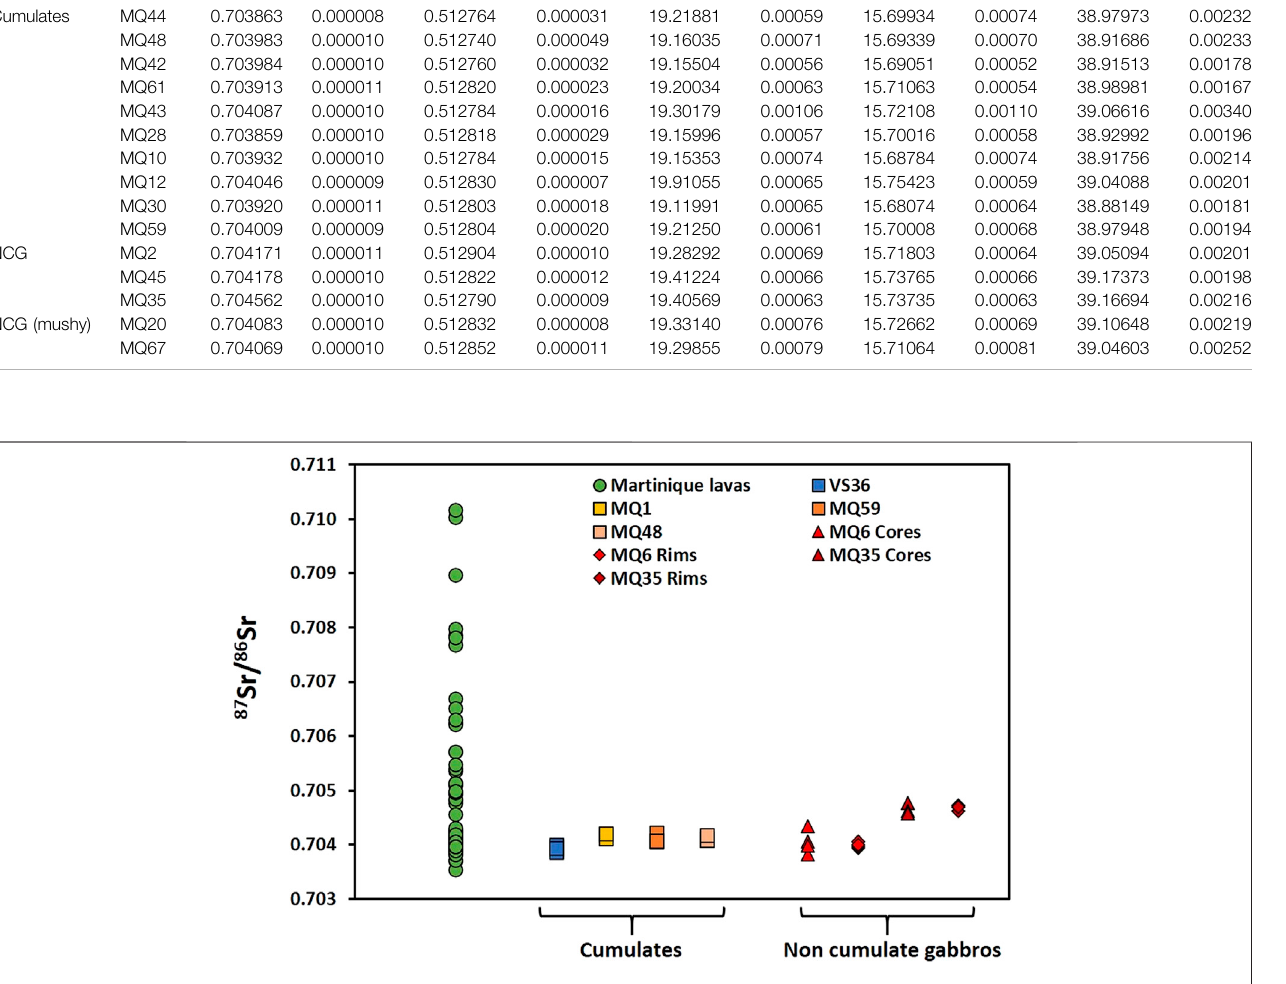
FIGURE 5 | 87 Sr/ 86 Sr of individual plagioclase in cumulates, and core and rim zones of plagioclase in NCG ’ s, compared with the whole rock 87 Sr/ 86 Sr range of Martinique lavas. Lava data from Davidson (1986) and Labanieh et al. (2010). For all data points, uncertainty (2 SE) is smaller than symbol size.